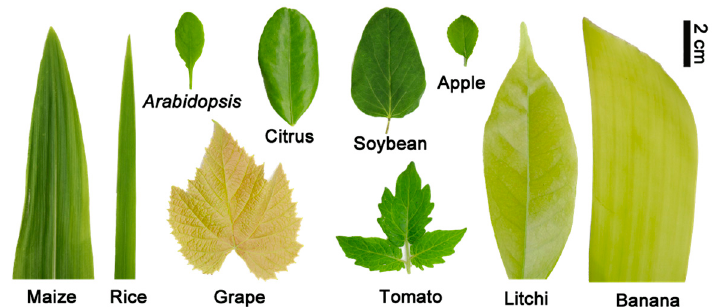
Figure 1. The images of sampling leaves from maize, rice, tomato, arabidopsis, soybean, banana, grape, litchi, citrus, and apple. Scale bars = 2 cm.